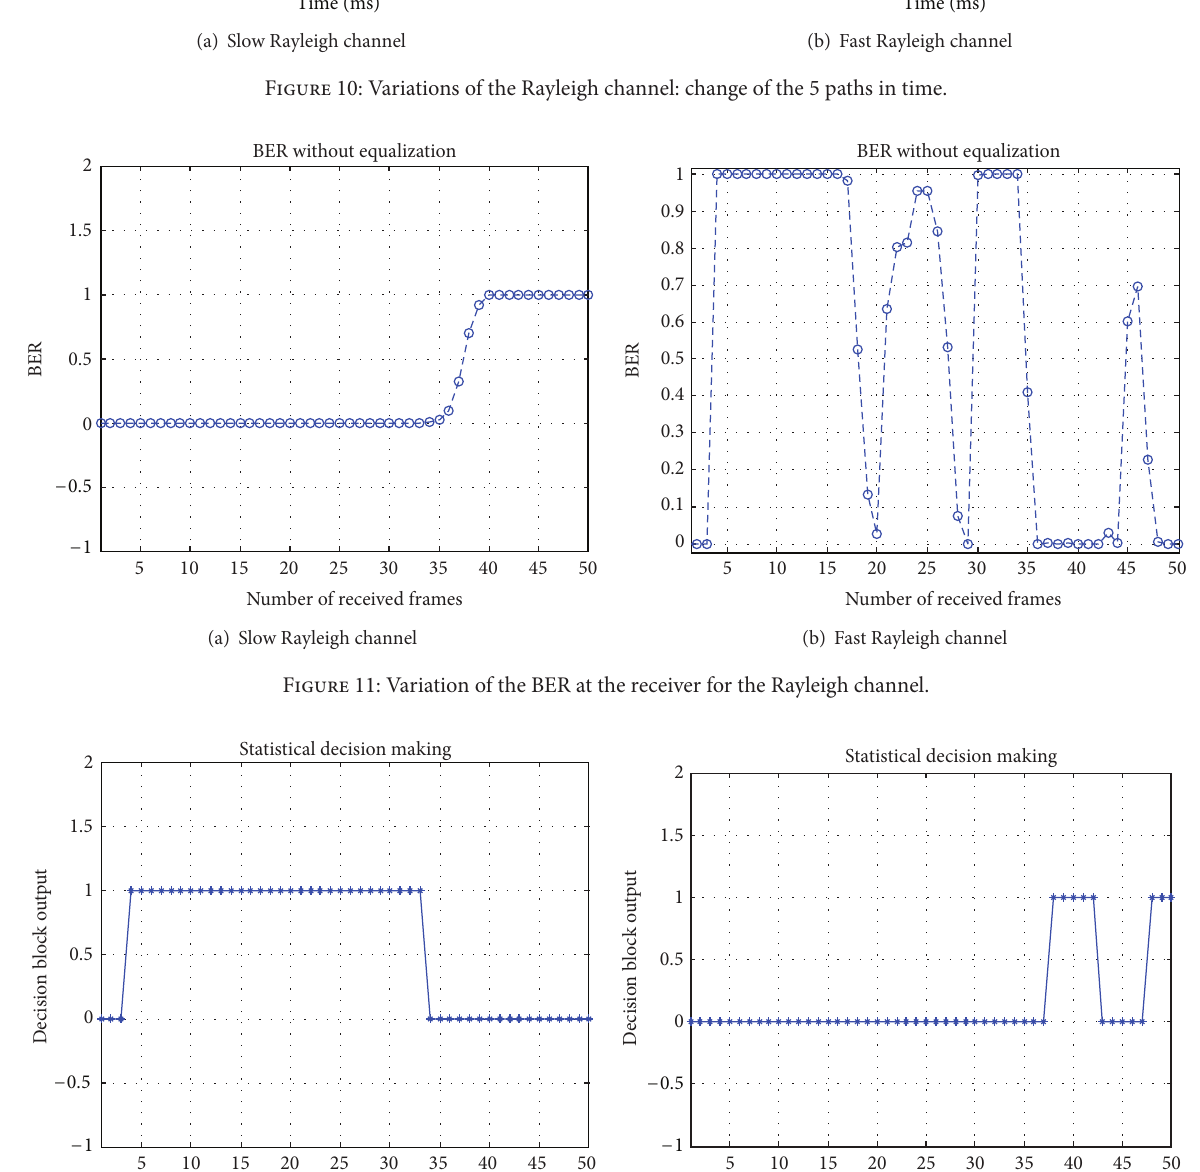
(b) Fast Rayleigh channel equalizer off, “0” equalizer → →